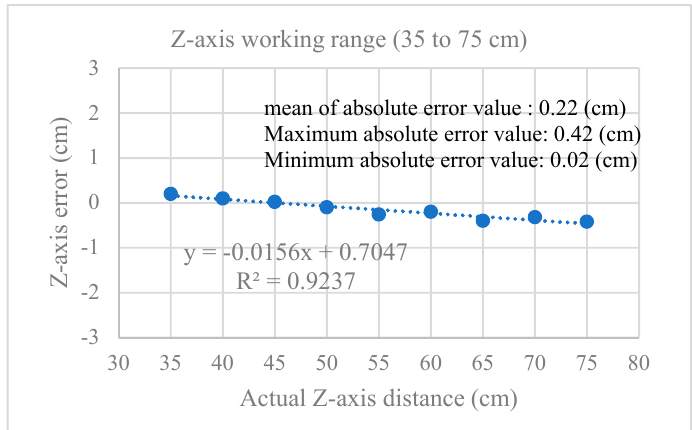
Figure 24. Z-axis error vs. Z-axis distance diagram (20 to 80 cm).